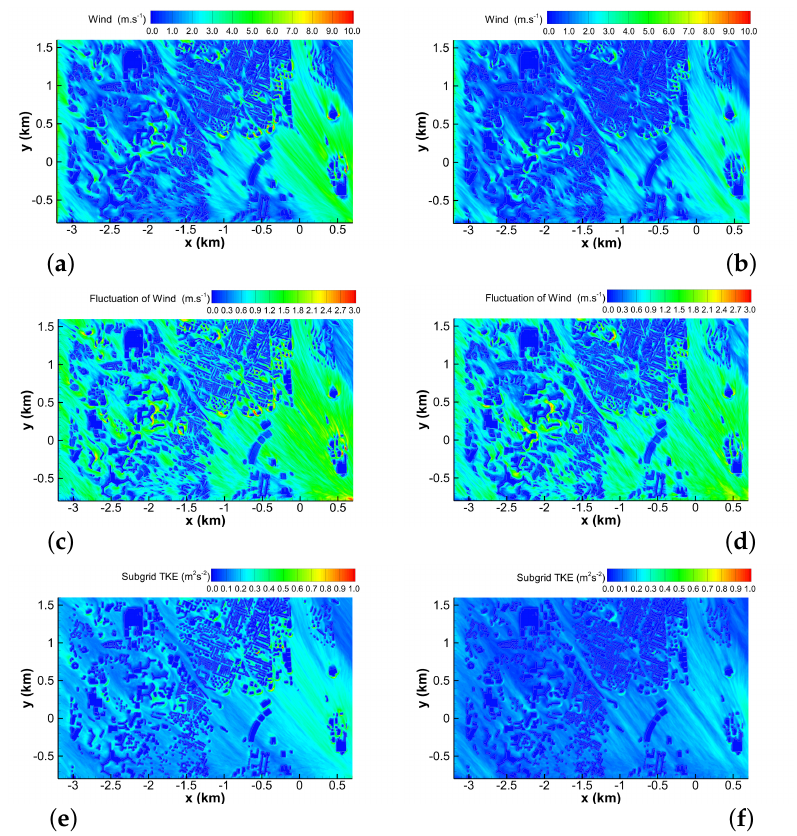
Figure 4. Surface map of the 15-min averages of the Gaussian integration of variables 1 m above the ground: ( a , b ) Wind speed; ( c , d ) wind fluctuations; ( e , f ) subgrid turbulence kinetic energy. The left column shows the results of the C 4/ C 2 advection scheme, and the right column W 5/ W 3. The left (resp. right) part shows the results of the C4/C2 (resp. W5/W3) advection